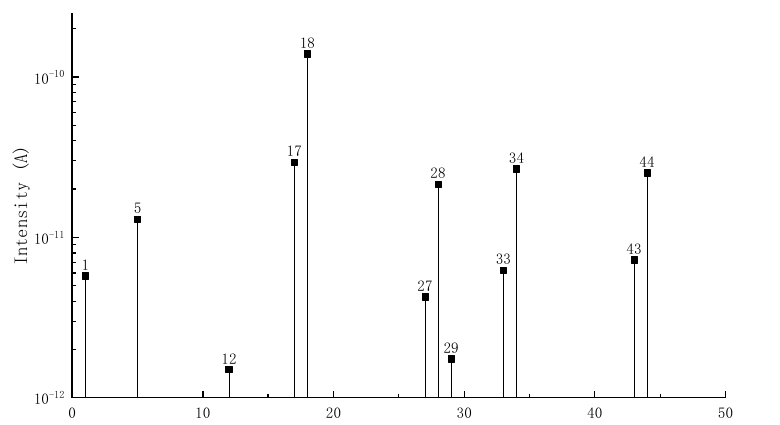
Figure 3. Mass spectrum of volatile matter from pyrolysis combustion of epoxy asphalt at charac- teristic temperature (342.8 °C).